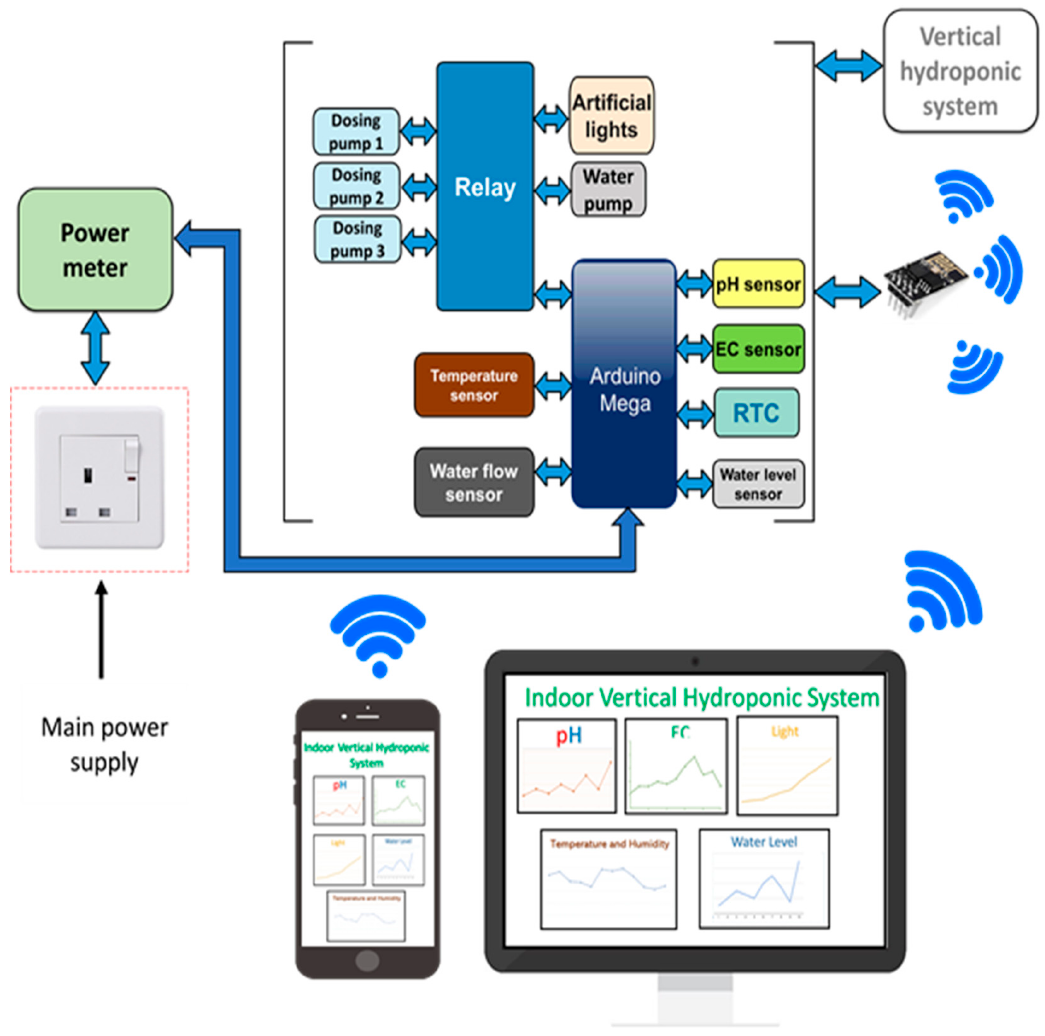
Figure 2. Block diagram of the designed system.